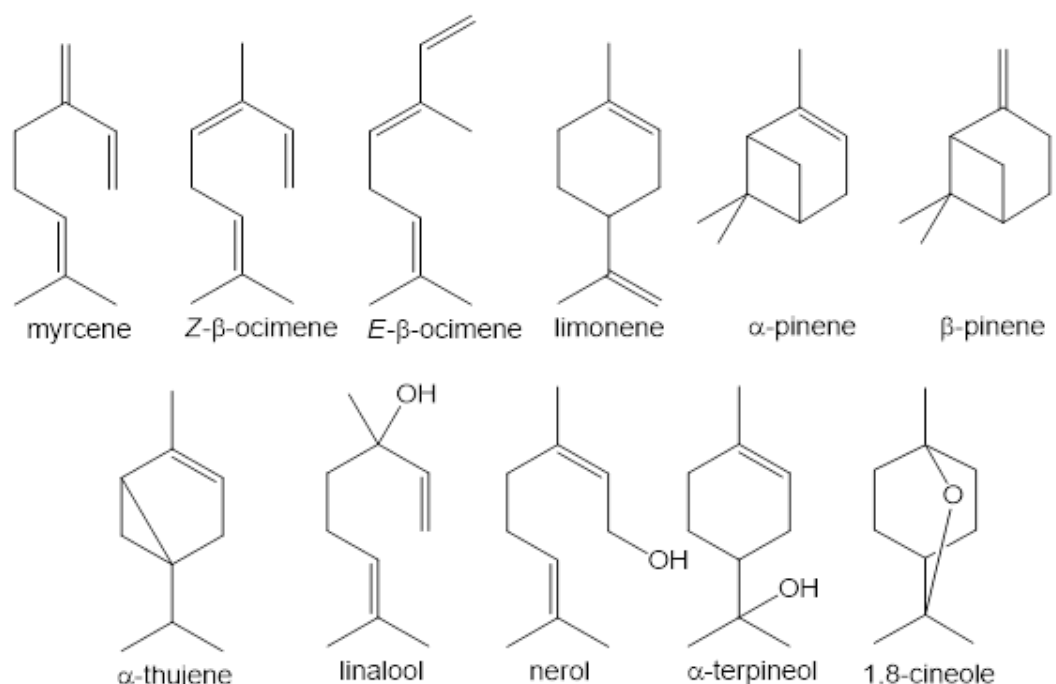
Eugenia and Syzygium essentials oils. Biomolecules 2020 , 10 , x FOR PEER REVIEW